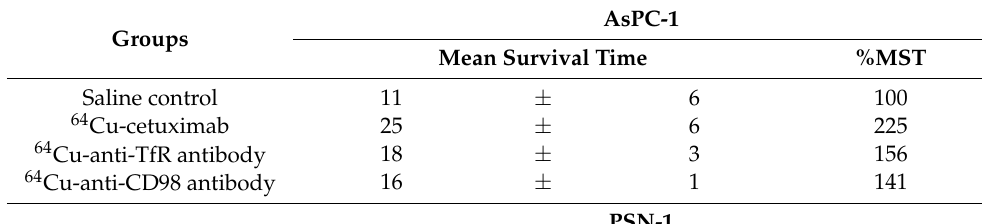
Table 2. Mean survival time (MST) from in vivo treatment study in the peritoneal dissemination mouse models of AsPC-1, PSN-1, and Capan-1 cell lines.